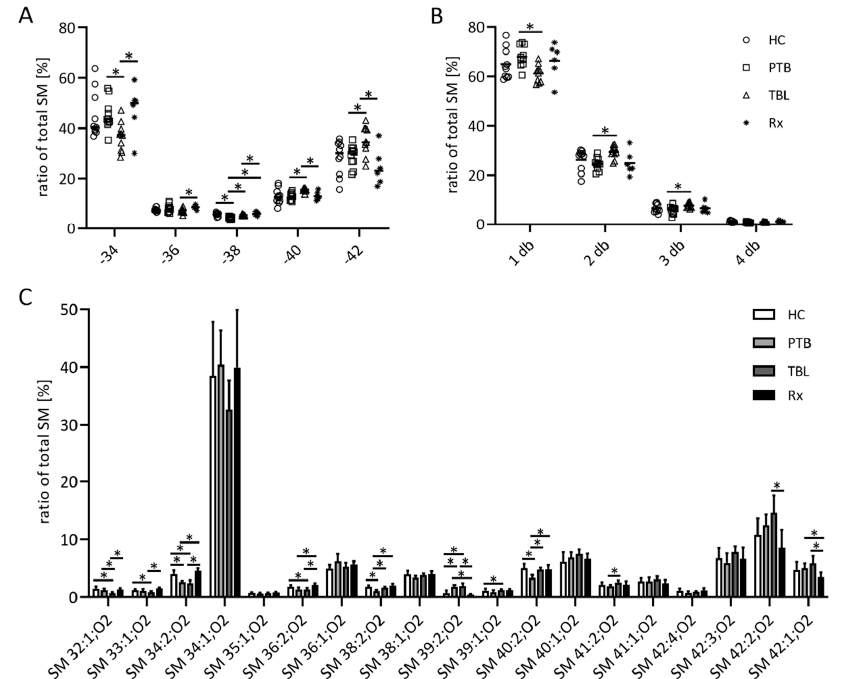
Figure 3. Composition of the sphingomyelin (SM) fraction of exosomes from TB patients. Organic extracts of exosome-derived lipids isolated from patients with pulmonary tuberculosis (PTB) and tuberculous lymphadenitis (TBL) as well as PTB-treated patients (Rx) were separated by high-performance thin layer chromatography. SM-containing spots were automatically eluted with methanol and directly analyzed by ESI-IT MS. The sum of SM species with up to 34, 36, 38, 40 and 42 C atoms ( A ) and the sum of SM species with one, two, three and four double bonds (db) ( B ) as well as the relative amounts of single SM species ( C ) were calculated from the sum of the signal intensities of all SM. Data sets in panels ( A ) and ( B ) are depicted as dot plots to show all single values, whereas data sets in panel ( C ) are depicted as bar graphs showing the mean and the positive standard deviation. Statistical significance was determined using the unpaired t test and the Holm–Sidak method to correct for multiple comparisons (alpha = 0.05). * p < 0.05.